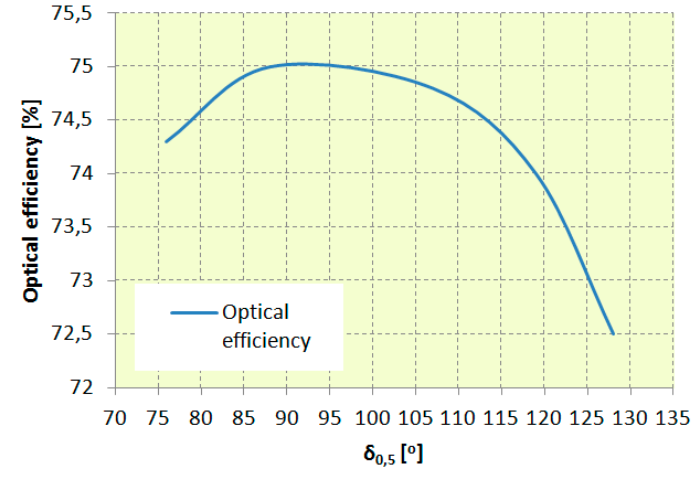
Figure 31. Optical efficiency of a luminaire as a function of beam angle.